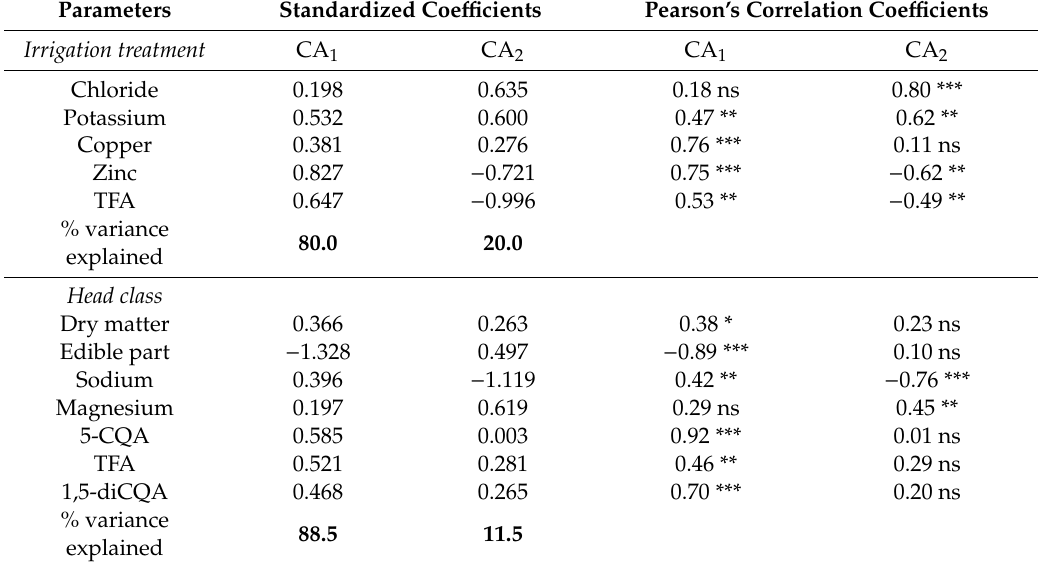
Table 6. Standardized coefficients (scores) and Pearson’s correlation coefficient for the first two canonical axes (CA 1-2 ), considering the different qualitative parameters of artichoke heads as selected by stepwise discriminant analysis (SDA). The corresponding percentages of accounted variation are also reported.